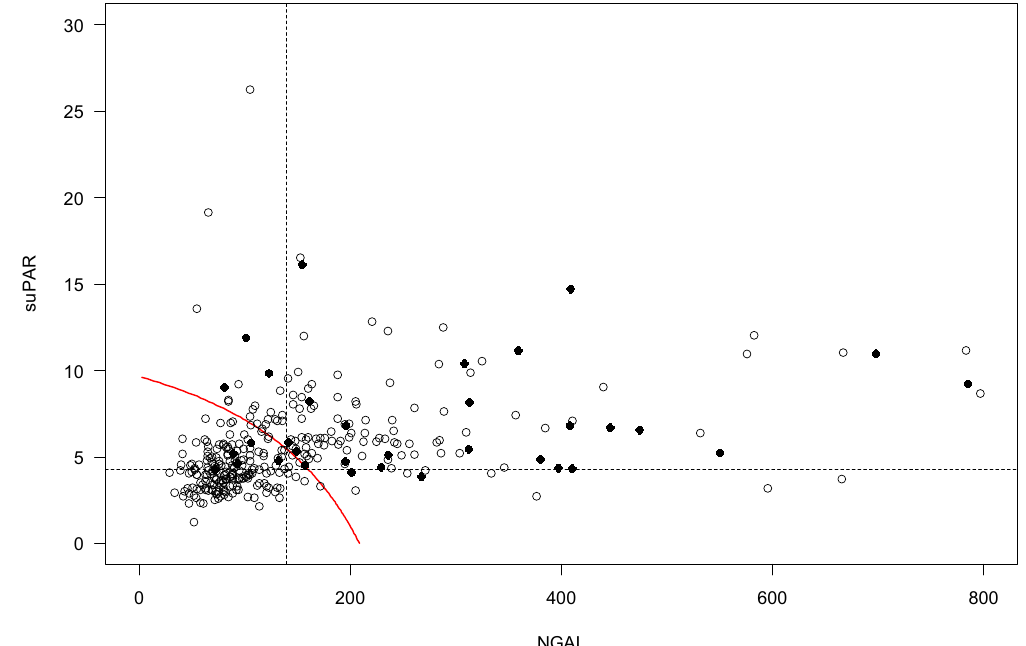
Figure 2. Receiver operating characteristic curve for predicting AKI. Model 1 includes suPAR; model 2 includes NGAL; and model 3 includes interaction between suPAR and NGAL (2-variable interaction).